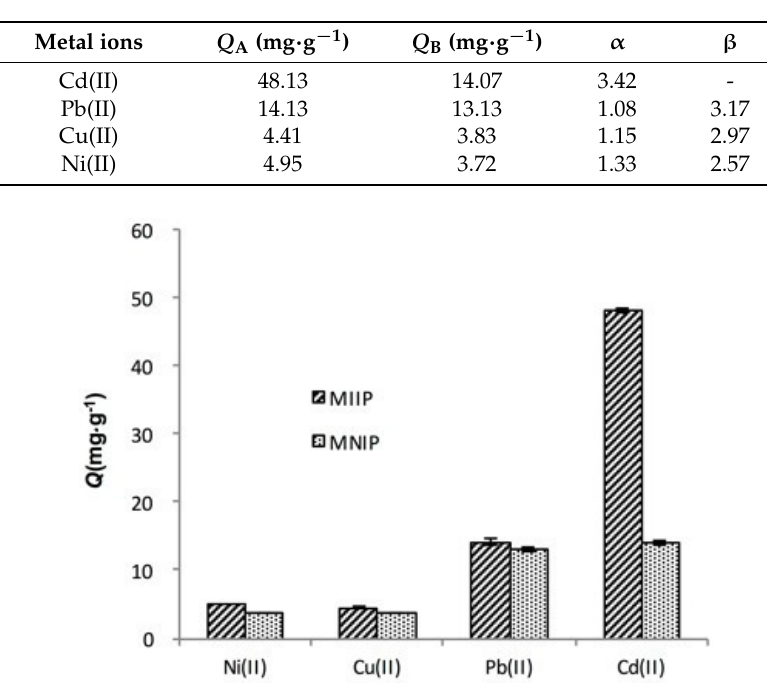
Figure 10. The adsorption capacities of Cd(II), Pb(II), Cu(II), and Ni(II) onto the MIIP and MNIP.